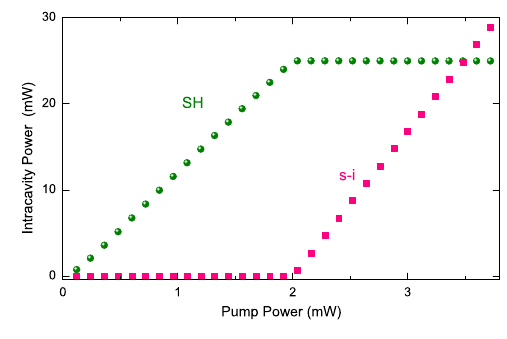
Figure 13: Doubly resonant SHG cavity. Numerical simulation of the intracavity second-harmonic and parametric power as a function of the pump